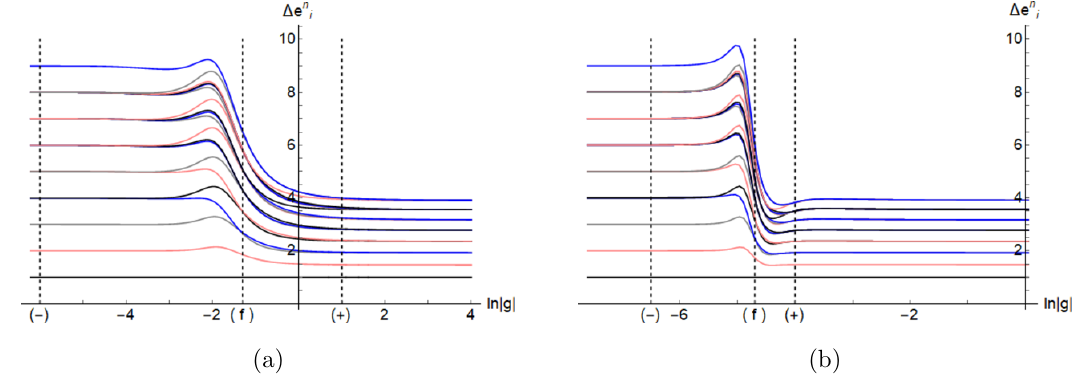
Figure 15. (a) Perturbation of NS fermions ( (cid:15) representation) by T with positive coupling; (b) Perturbation of NS fermions ( (cid:15) representation) by T with negative